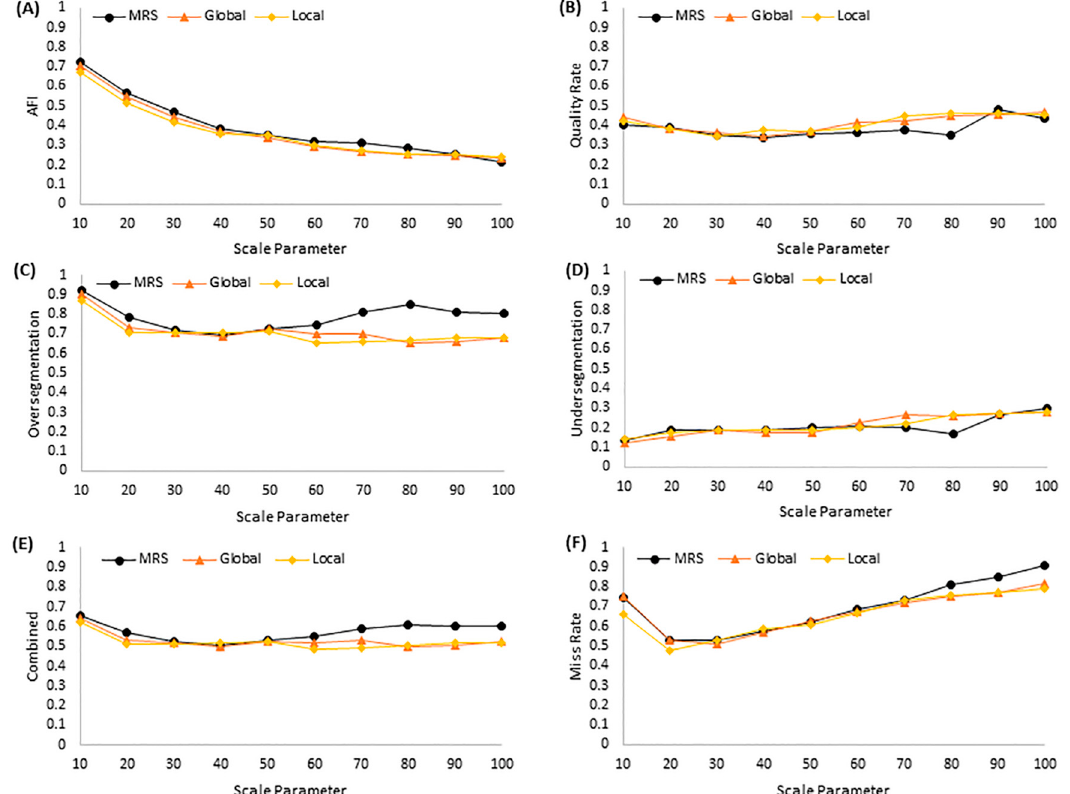
Figure 4. The supervised evaluation results for the segmentations of spectral data produced from three segmentation methods (MRS, Global, and Local) according to the discrepancy measures: ( A ) Area fit index; ( B ) quality rate; ( C ) over segmentation; ( D ) under segmentation; ( E ) combined over and under-segmentation; and ( F ) miss Rate.